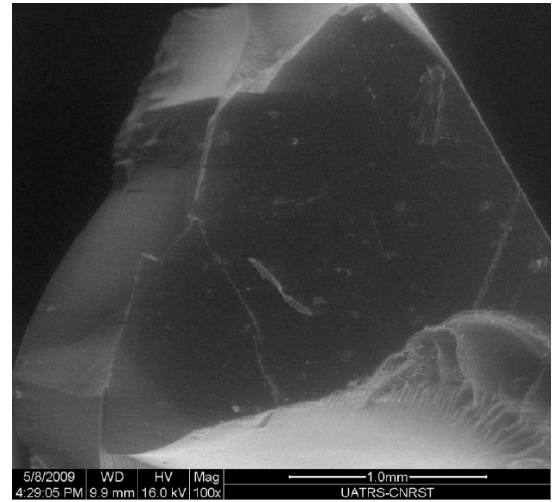
Figure 4. SEM micrograph of the DGEBA samples mixed with HGCP.